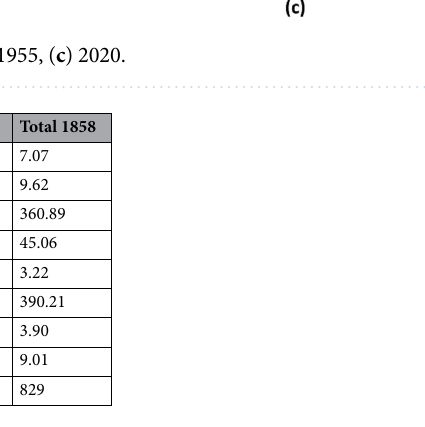
Table 8. LULC change matrix between 1858 and 1955 in the Kestel region (areas in hectares). Significant values are in [bold, italics].